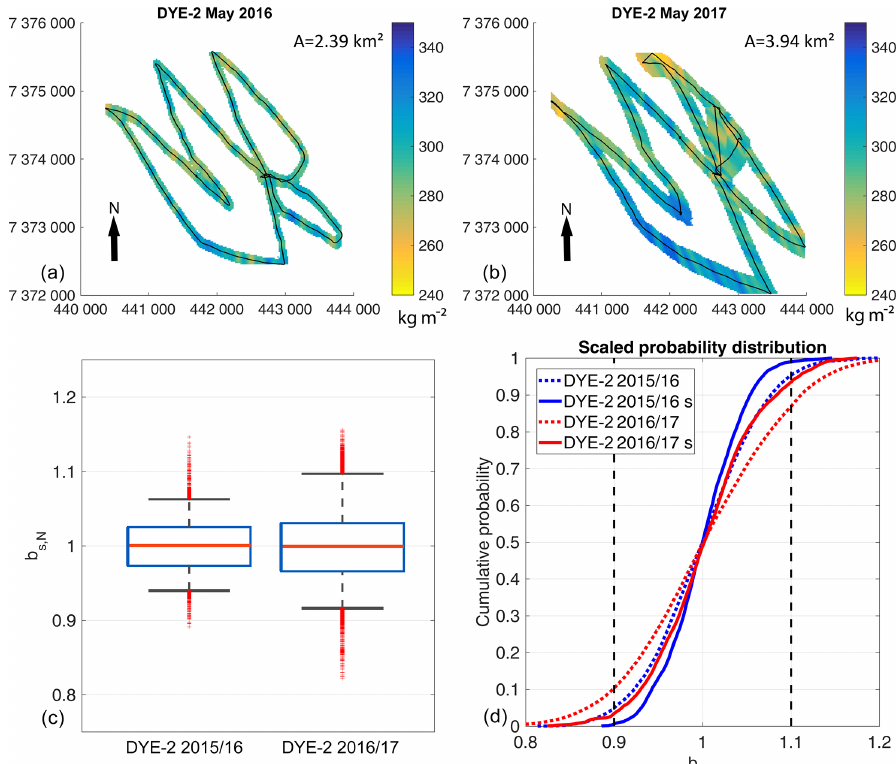
Figure 6. (a, b) Kriging results for the radar transect at DYE-2 for snow accumulation. The black lines show the recorded radar traces, and the black arrows indicate geographic north. The letter A is the total area covered by extrapolation. (c) Box plots displaying normalized data distribution ( b s , N ) of kriged outputs with the red horizontal line showing the median, the blue box framing the interquartile range, and the whiskers displaying the 5th and 95th percentiles. Outliers are shown as red crosses. (d) Normalized cumulative probability distribution of radar-derived b s within any subset with a 1m radius of the GPR transects. The dashed vertical lines represent the determined error margins of ± 10%. Compared are filtered (solid lines and letter s) with unfiltered (dotted lines) radar transects. All map coordinates are given in UTM zone 23N with datum WGS